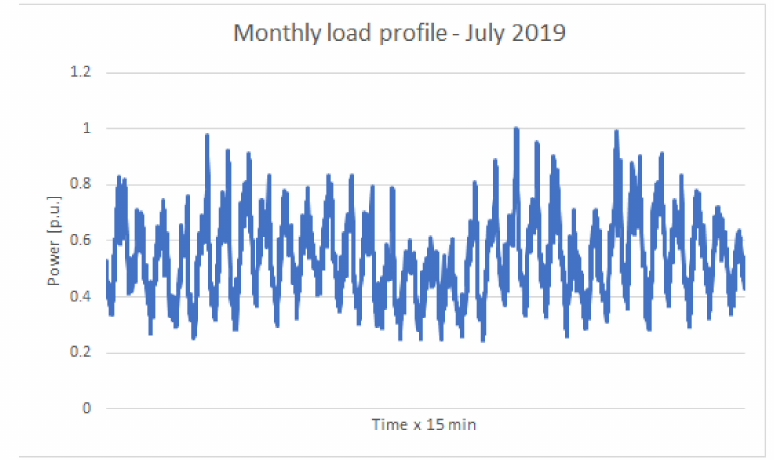
Figure 4. Example of a secondary substation’s monthly load profile in p.u. of the maximum